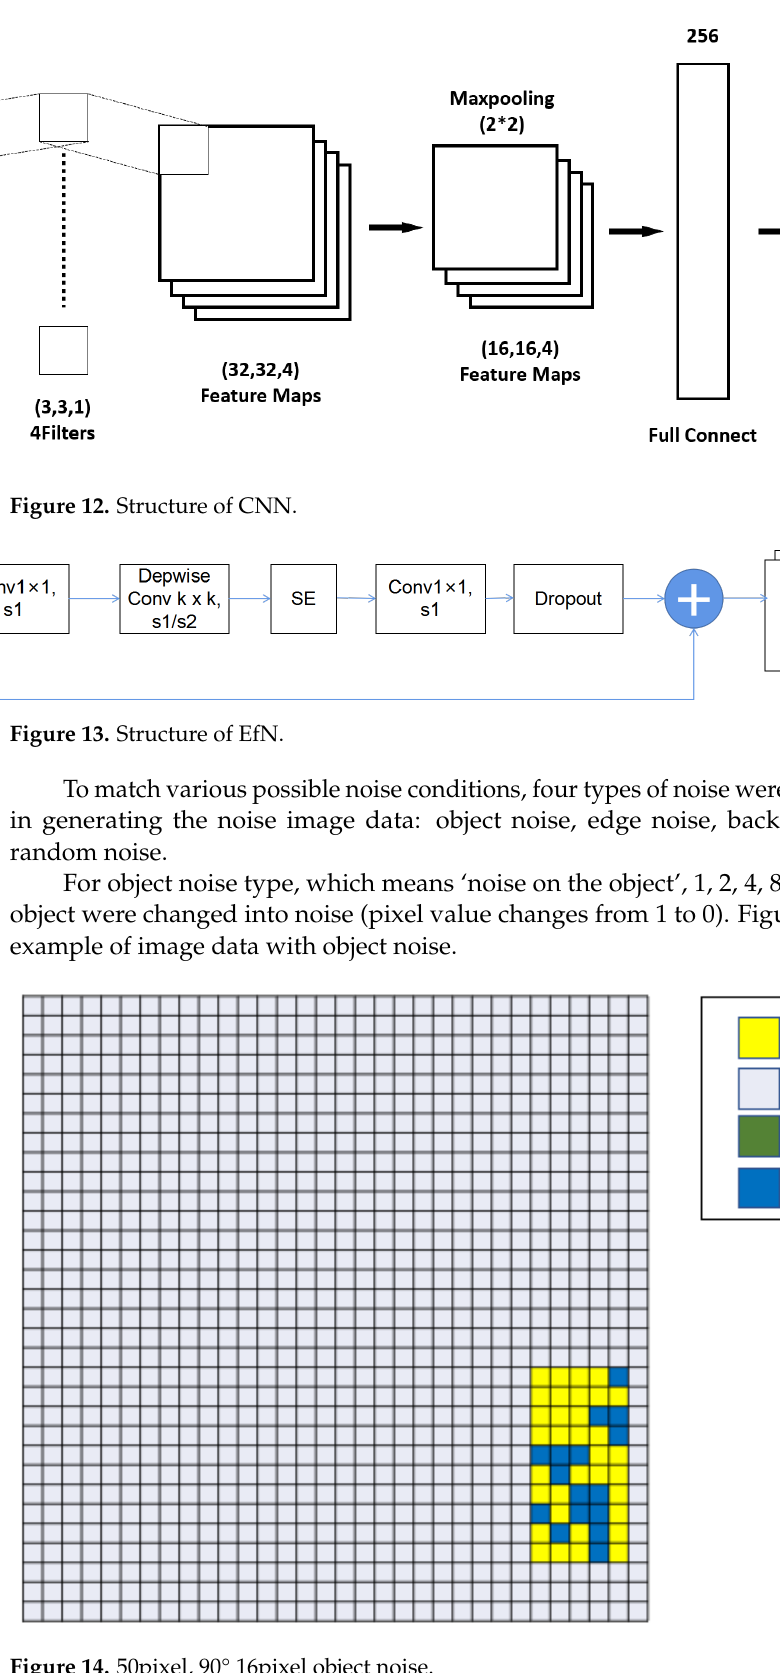
Figure 14. 50pixel, 90° 16pixel object